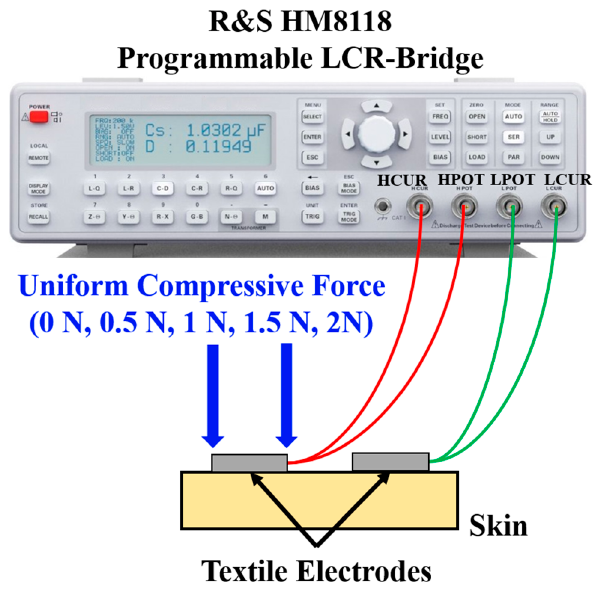
Figure 5. ETI Measurement using LCR bridge.